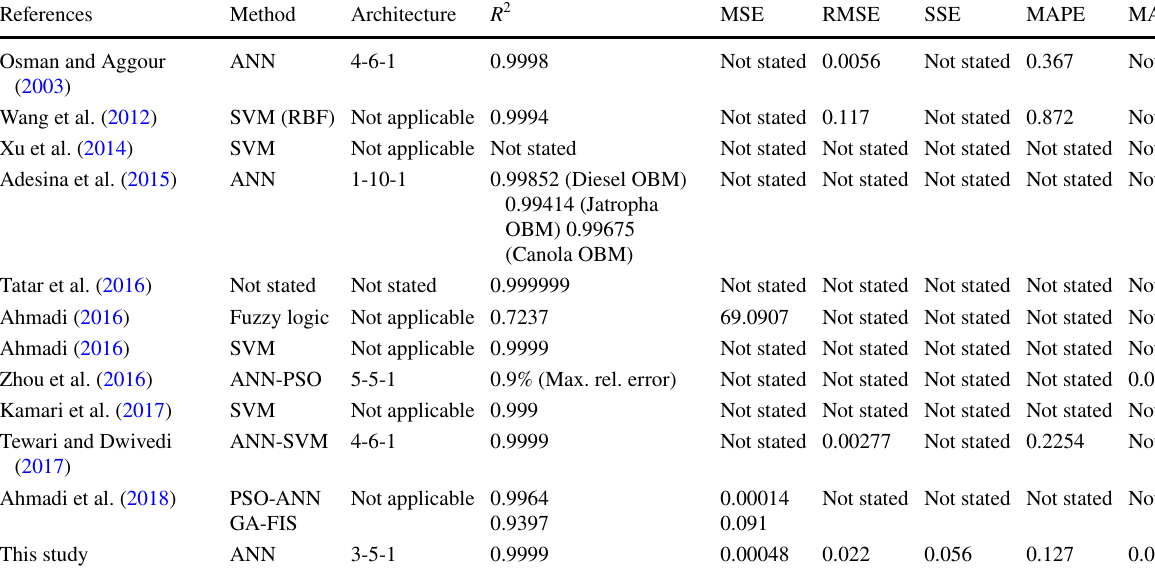
Table 10 Comparison of developed model with existing AI